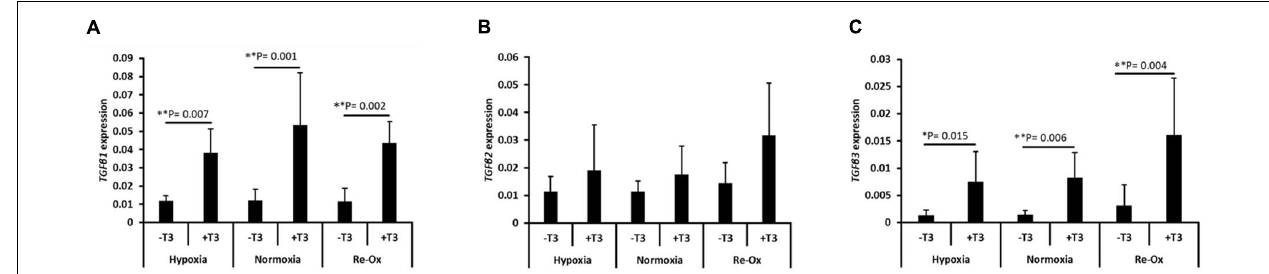
FIGURE 6 | Induction of the gene expression of transforming growth factor- β (TGF β ) isoforms in IFP-MSC pellets after 21 days of in vitro culture. Relative mRNA expression of (A) TGF β 1 , (B) TGF β 2 , and (C) TGF β 3 for seven donors with independent duplicates ( N = 7, n = 14 per experimental group). Gene expression was normalized to the geometric mean of three housekeeping genes ( YWHAZ , β -actin , and B2M ). Bar data are mean ± standard deviation. Statistical comparisons were based on Kruskal–Wallis test between without TGF β 3 (i.e., –T3) and with TGF β 3 (i.e., +T3) supplementation groups within an oxygen tension group. ∗ p -value < 0.05; ∗∗ p -value < 0.01.